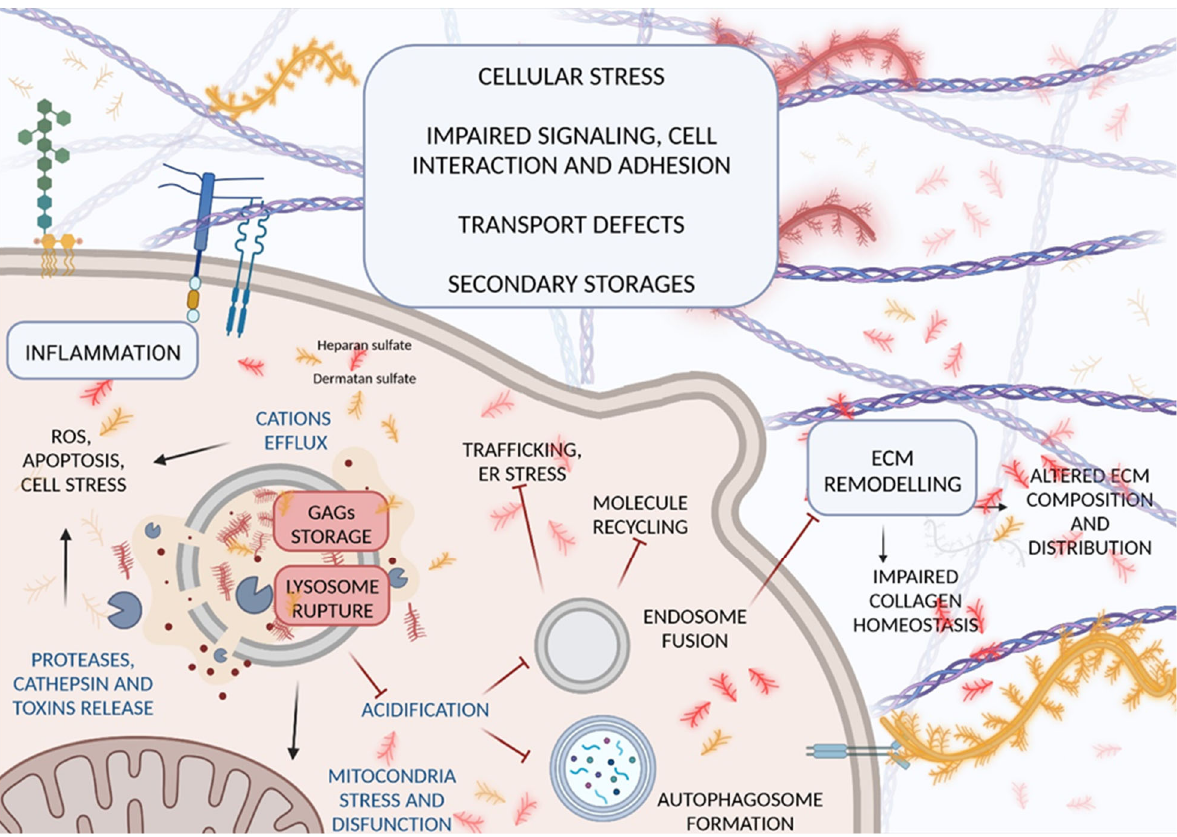
Figure 3. Representative pathological MPSI cascade. GAG accumulation inside the lysosome could be responsible for lysosome rupture with subsequent release of proteases, cathepsins, and toxic products inside the cytoplasm. This could potentially result in mitochondrial oxidative stress, ROS formation, impaired cell function, and eventually, apoptosis. Created with BioRender.com (accessed on 20 September 2022).